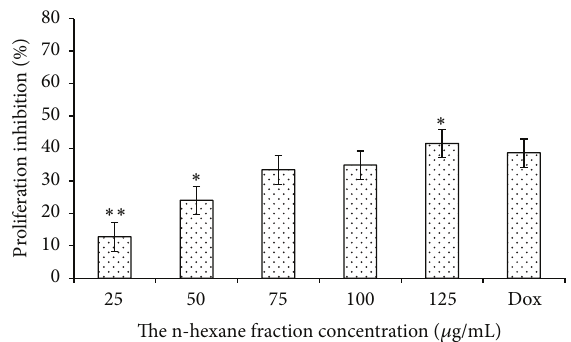
Figure 2: Percentage of proliferation inhibition MCM-B2 cells after treatment with n-hexane fraction of clove mistletoe. The data is expressed as percentage of proliferation inhibition ± SEM, as compared to the negative control (100%). Level of significance is denoted as follows: ∗ 𝑃 < 0.05 ; ∗∗ 𝑃 < 0.01